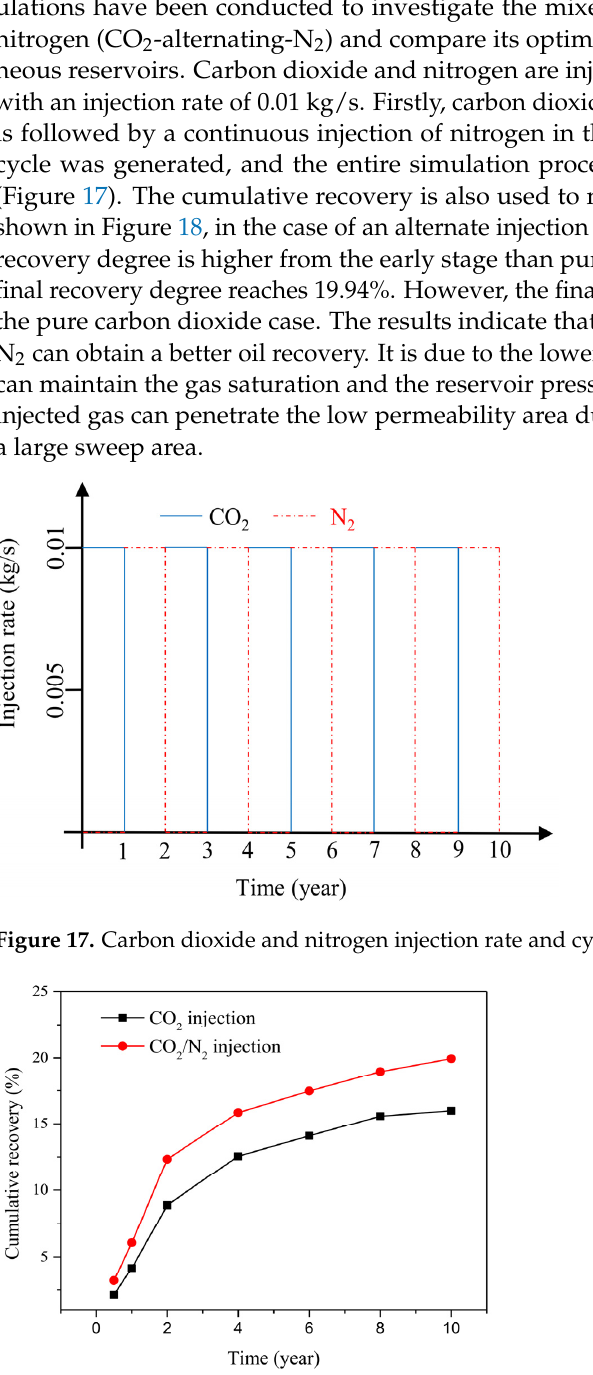
Figure 18. Effect of CO 2 or CO 2 /N 2 injection on oil cumulative recovery.